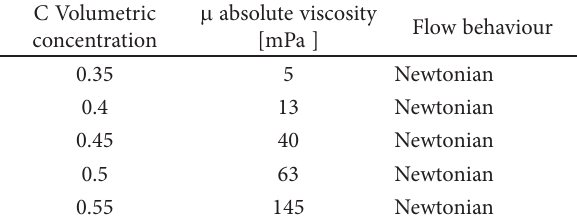
Table 14. Flow properties of red Mud, India: